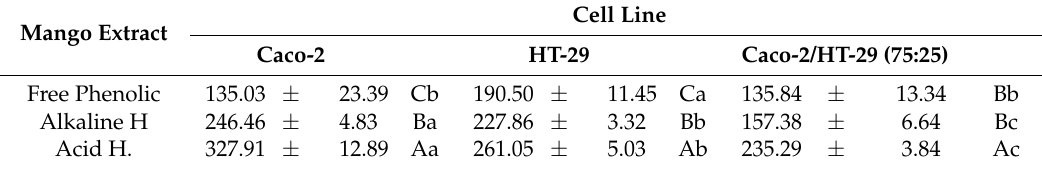
Table 2. Antiproliferative activity of Mango cv. Ataulfo peel extracts fractions, against Caco-2, HT-29 cell lines, and in combination 75:25%. Values were expressed as the half maximal inhibitory concentration (IC 50 ) in µg/mL.